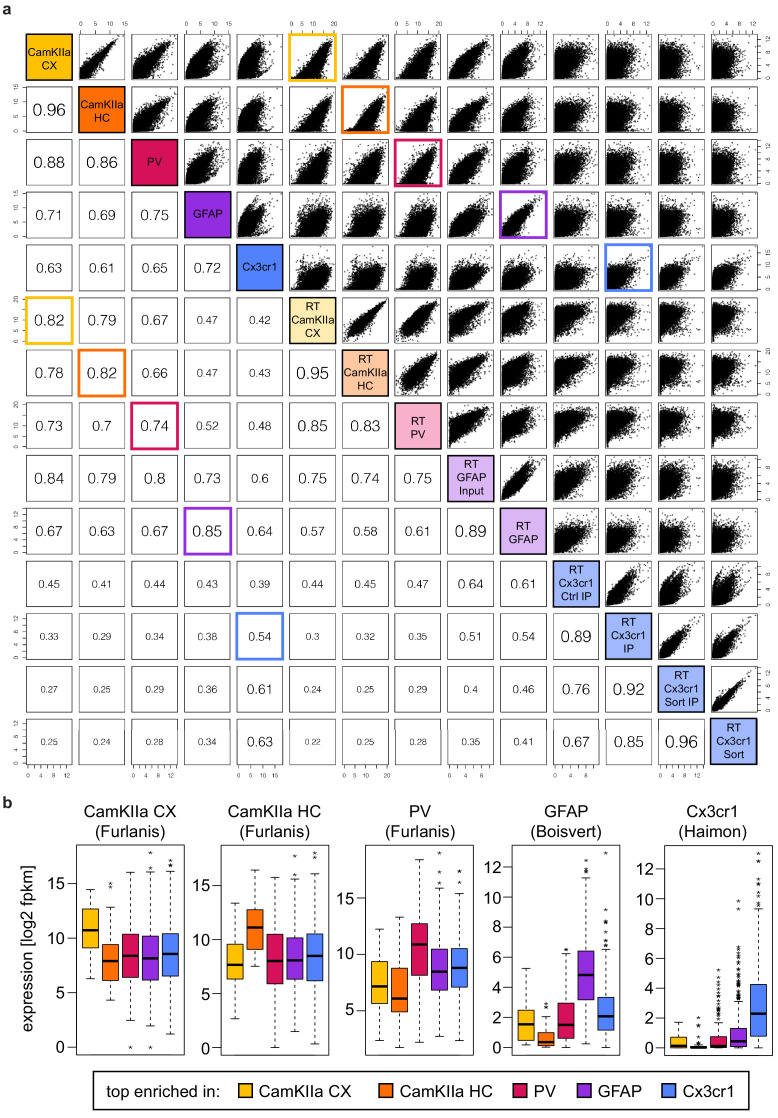
Comparison of cell-type-specific expression and translation.(a) Cross-correlation plot comparing ribosome profiling (RP; samples #1–5) and ribotag (RT; samples #6–14) data. Pearson correlation coefficients are indicated. RP and RT samples generated from the same cell type showed the highest correlation and the comparisons are highlighted in the corresponding color. (b) Boxplots displaying the expression (according to RT data) of preferentially translated genes (PTGs). PTGs showed the highest expression in the corresponding RT datasets.